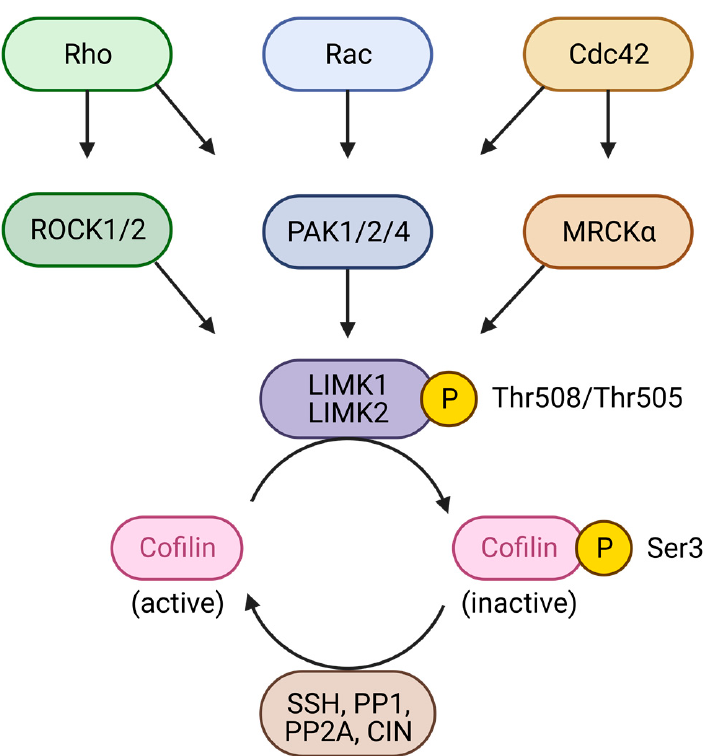
Figure 2. Cofilin regulation by LIM kinases, downstream of Rho GTPase family signalling pathways.